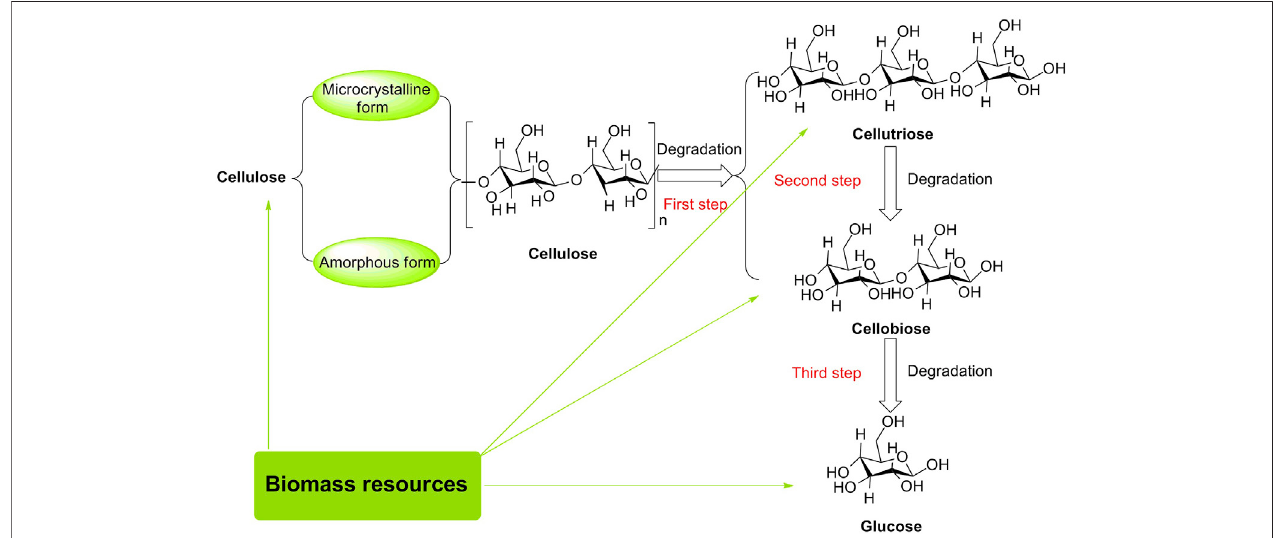
FIGURE 2 | General route to selective biomass conversions of cellulose to